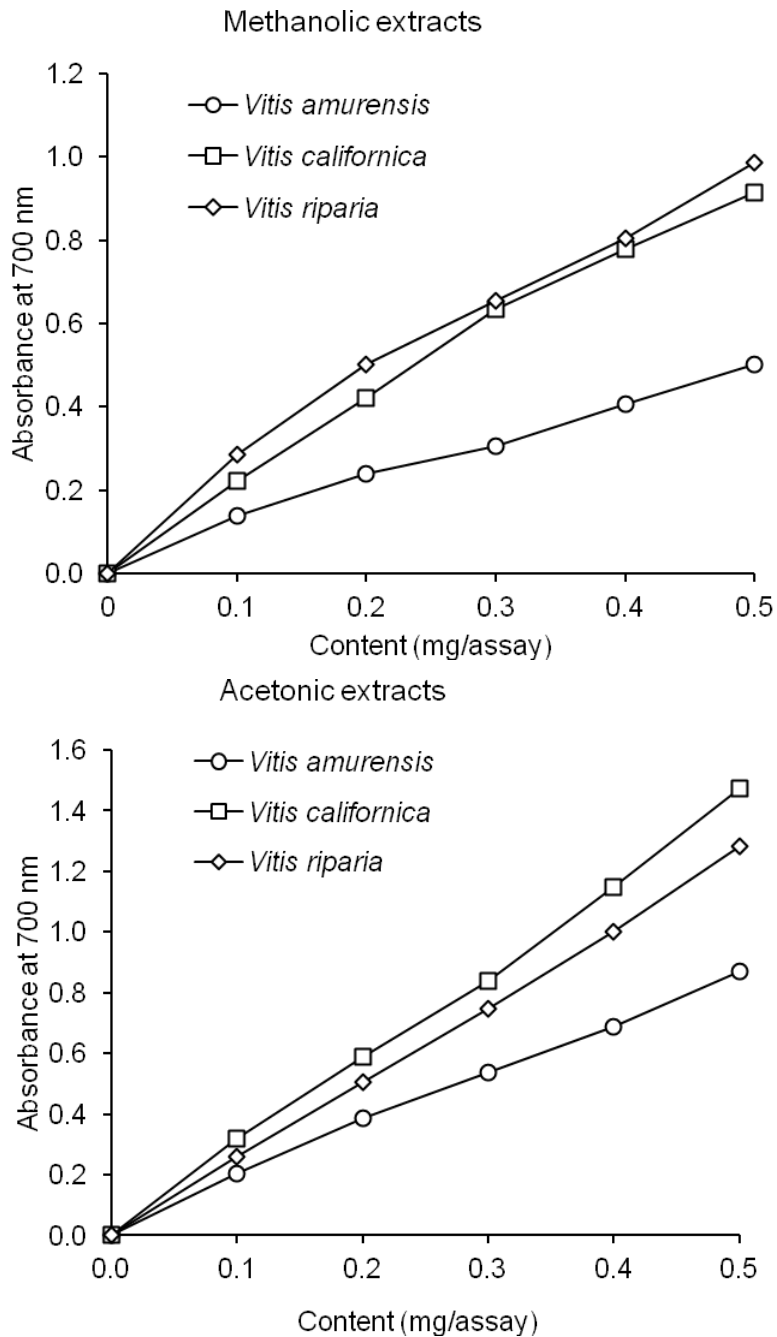
Figure 3. Reducing power of the methanolic and acetonic extracts of grapevine